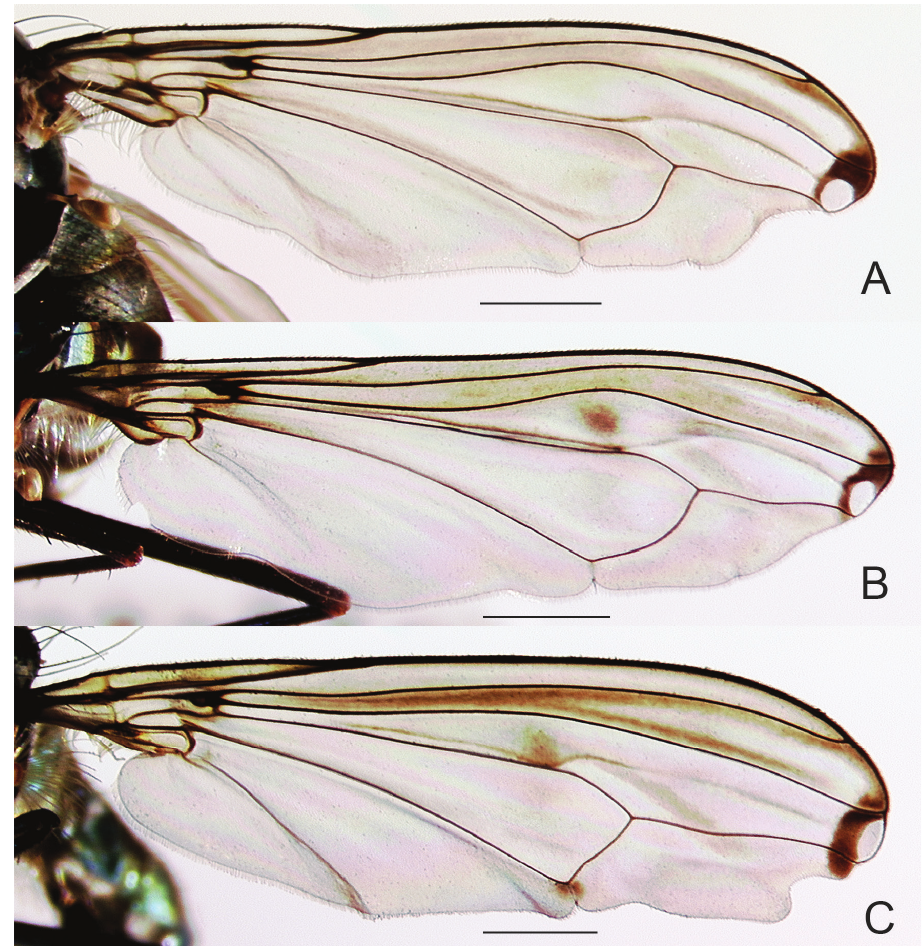
Figure 5. Wings of male A Liancalus genualis Loew B L. sonorus sp. n., and C L. limbatus Van Duzee. Scale bars = 1